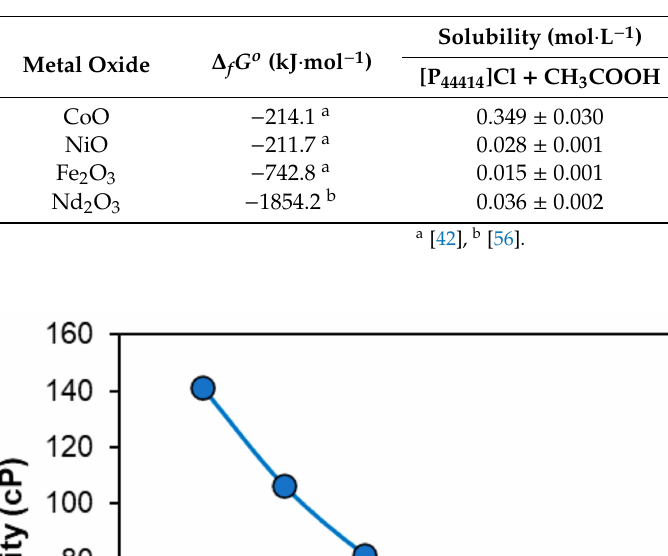
Table3. Gibbsenergyofformation( ∆ f G o )andsolubilityforselectedmetaloxidesin[P 44414 ]Cl + CH 3 COOH after 24 hr at 323 K compared to that in choline chloride ([Ch]Cl)) + CH 3 COOH (1:2) DES.